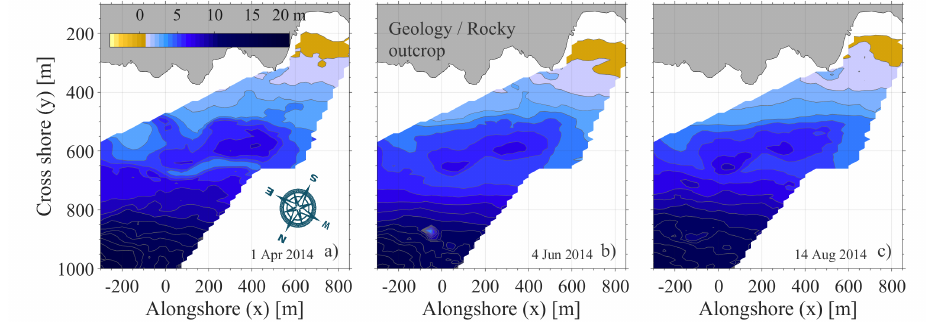
Figure 5. Morphology during calm conditions shown approximately every two months: 1 April 2014 ( a ), 4 June 2014 ( b ) and 14 August 2014 ( c ).